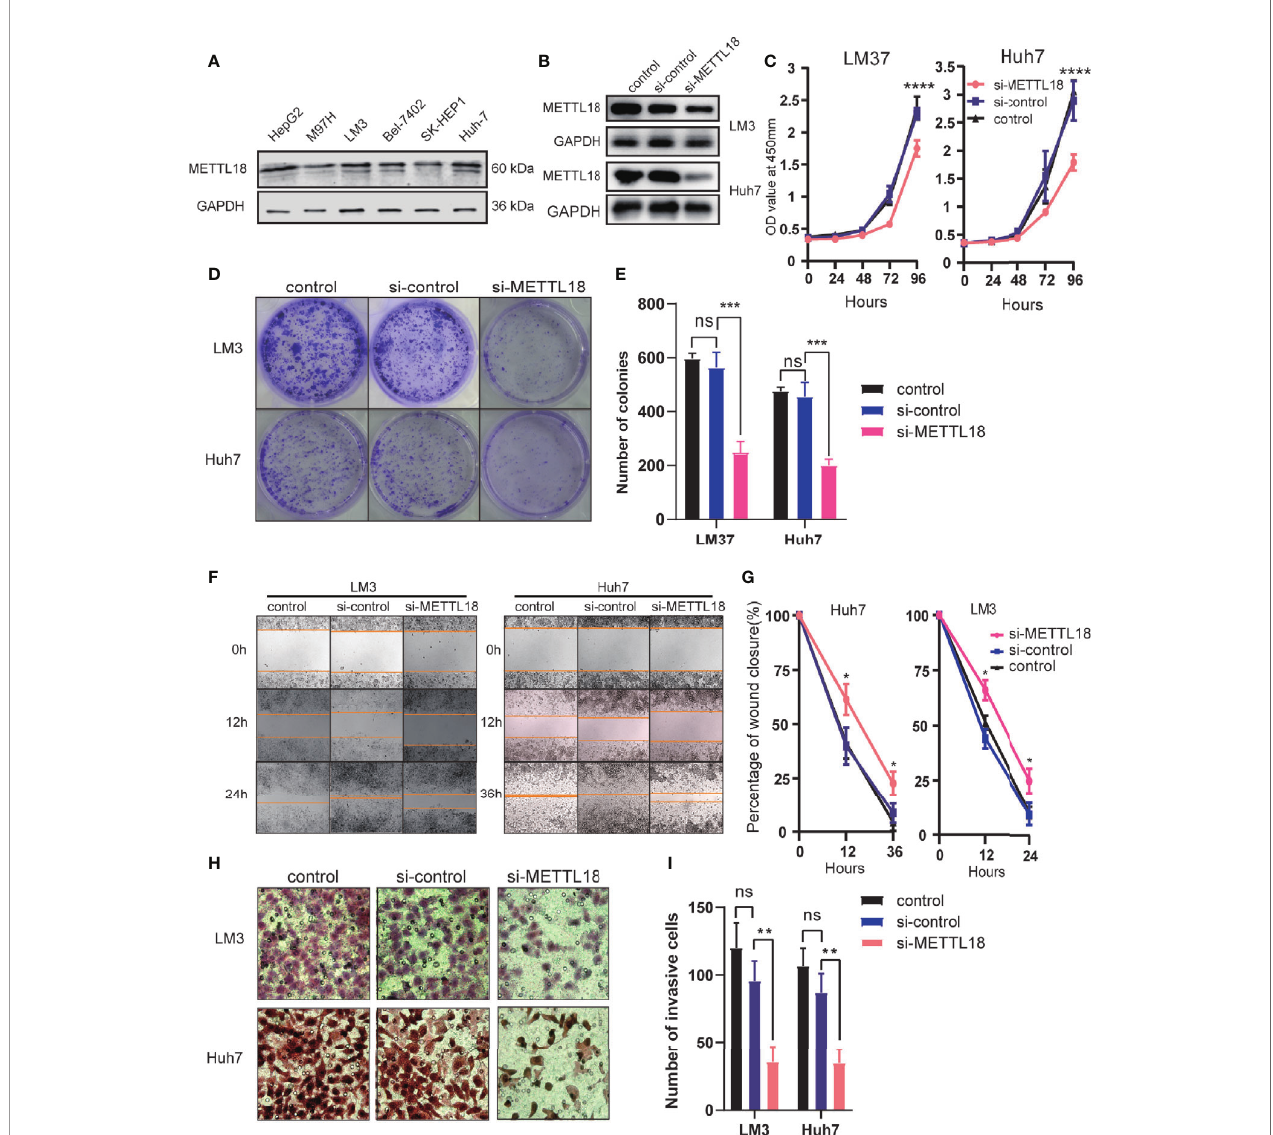
FIGURE 7 | Decreased the expression of METTL18 inhibits proliferation, invasion, and migration of liver cancer cells in vitro . (A) The expression of METTL18 in the HepG2, M97H, LM3, Bel7402, SK-HEP1, and Huh7 cell lines were detected by western blotting, respectively. (B) The transfection ef fi ciency of si-METTL18 in the LM3 and Huh7 cell lines explores by western blotting. (C) The CCK-8 assay was applied to detect the ef fi ciency of METTL18 knockdown on the proliferation of LM3 and Huh7 cell lines. (D) Images of the colony formation assay after knockdown of METTL18 in the LM3 and Huh7 cell lines. (E) Representational statistical analysis of the colony formation assay, including control, si-control, and si-METTL18 groups. (F) Representational images of the wound healing assay. (G) Statistical analysis of the wound healing assay results after decreased expression of METTL18. (H) Images of the transwell assay results after knockdown of METTL18 in the LM3 and Huh7 cell lines. (I) Representational statistical analysis of the transwell assay. *p < 0.05, **p < 0.01, ***p < 0.001, ****p < 0.0001, NS, no signi fi